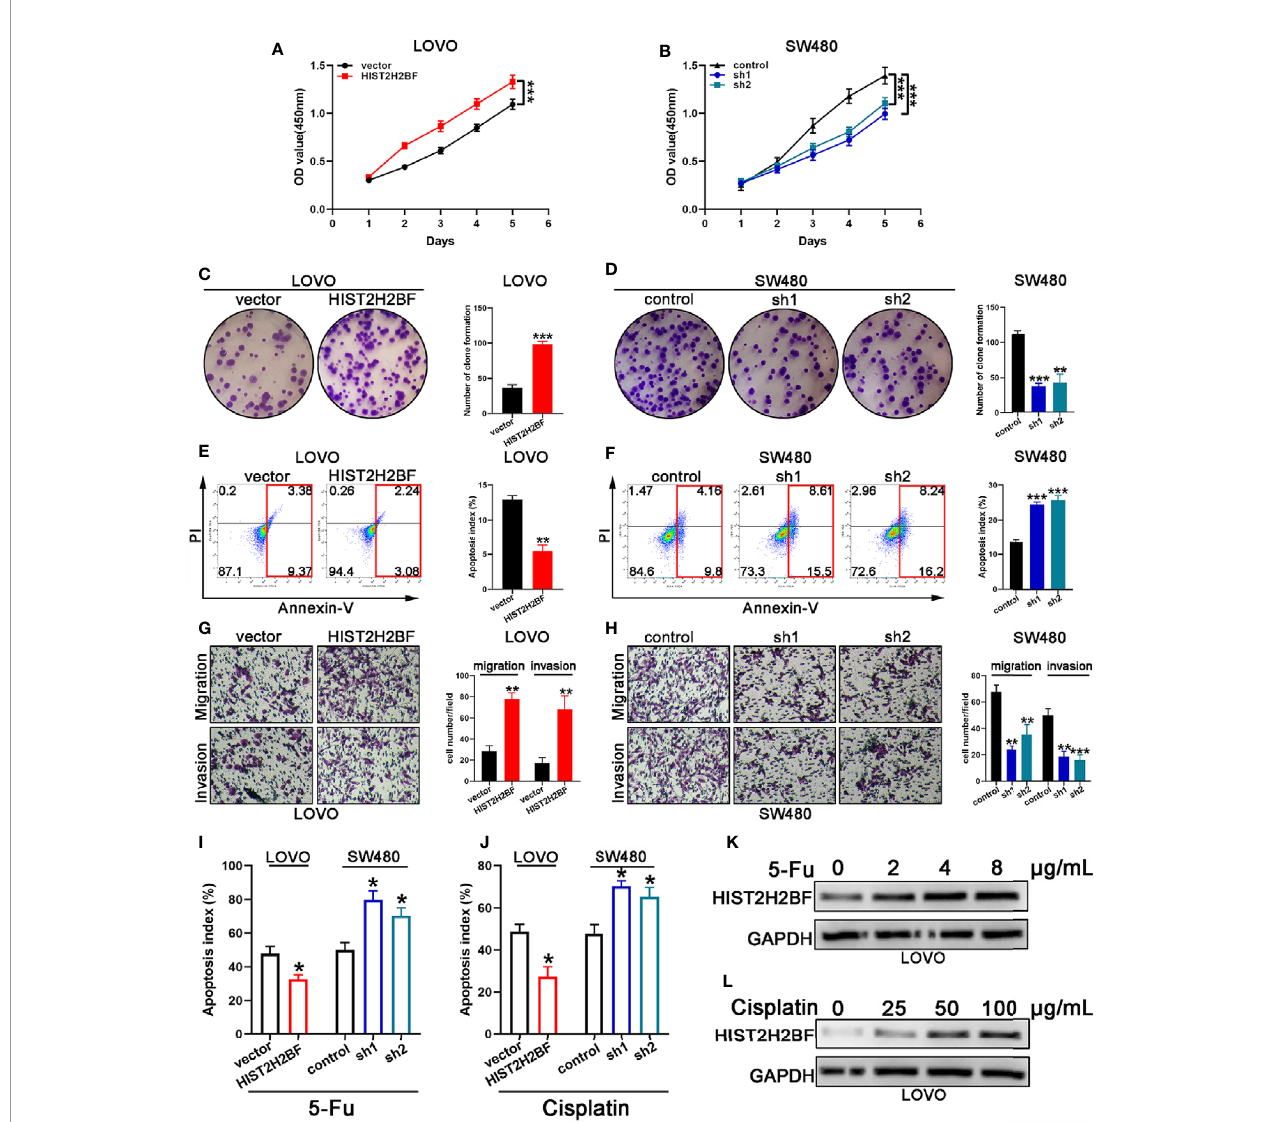
FIGURE 4 | HIST2H2BF promoted proliferation, migration, invasion, and drug resistance in CRC. (A, B) Growth curves were recorded using CCK8 assays. (C, D) Colony formation assays of CRC cells; the number of colonies in each well was then counted. (E, F) Apoptosis of CRC cells was analyzed using a fl ow cytometer. (G, H) Migration and invasion assays of CRC cells; the number of migrated and invaded CRC cells were then counted. (I, J) Apoptosis of CRC cells was detected after 5-FU and cisplatin treatment. (K, L) Western blotting indicating HIST2H2BF expression in LOVO cells after treatment with various concentrations of 5-FU and cisplatin. *P < 0.05, **P < 0.01, ***P <